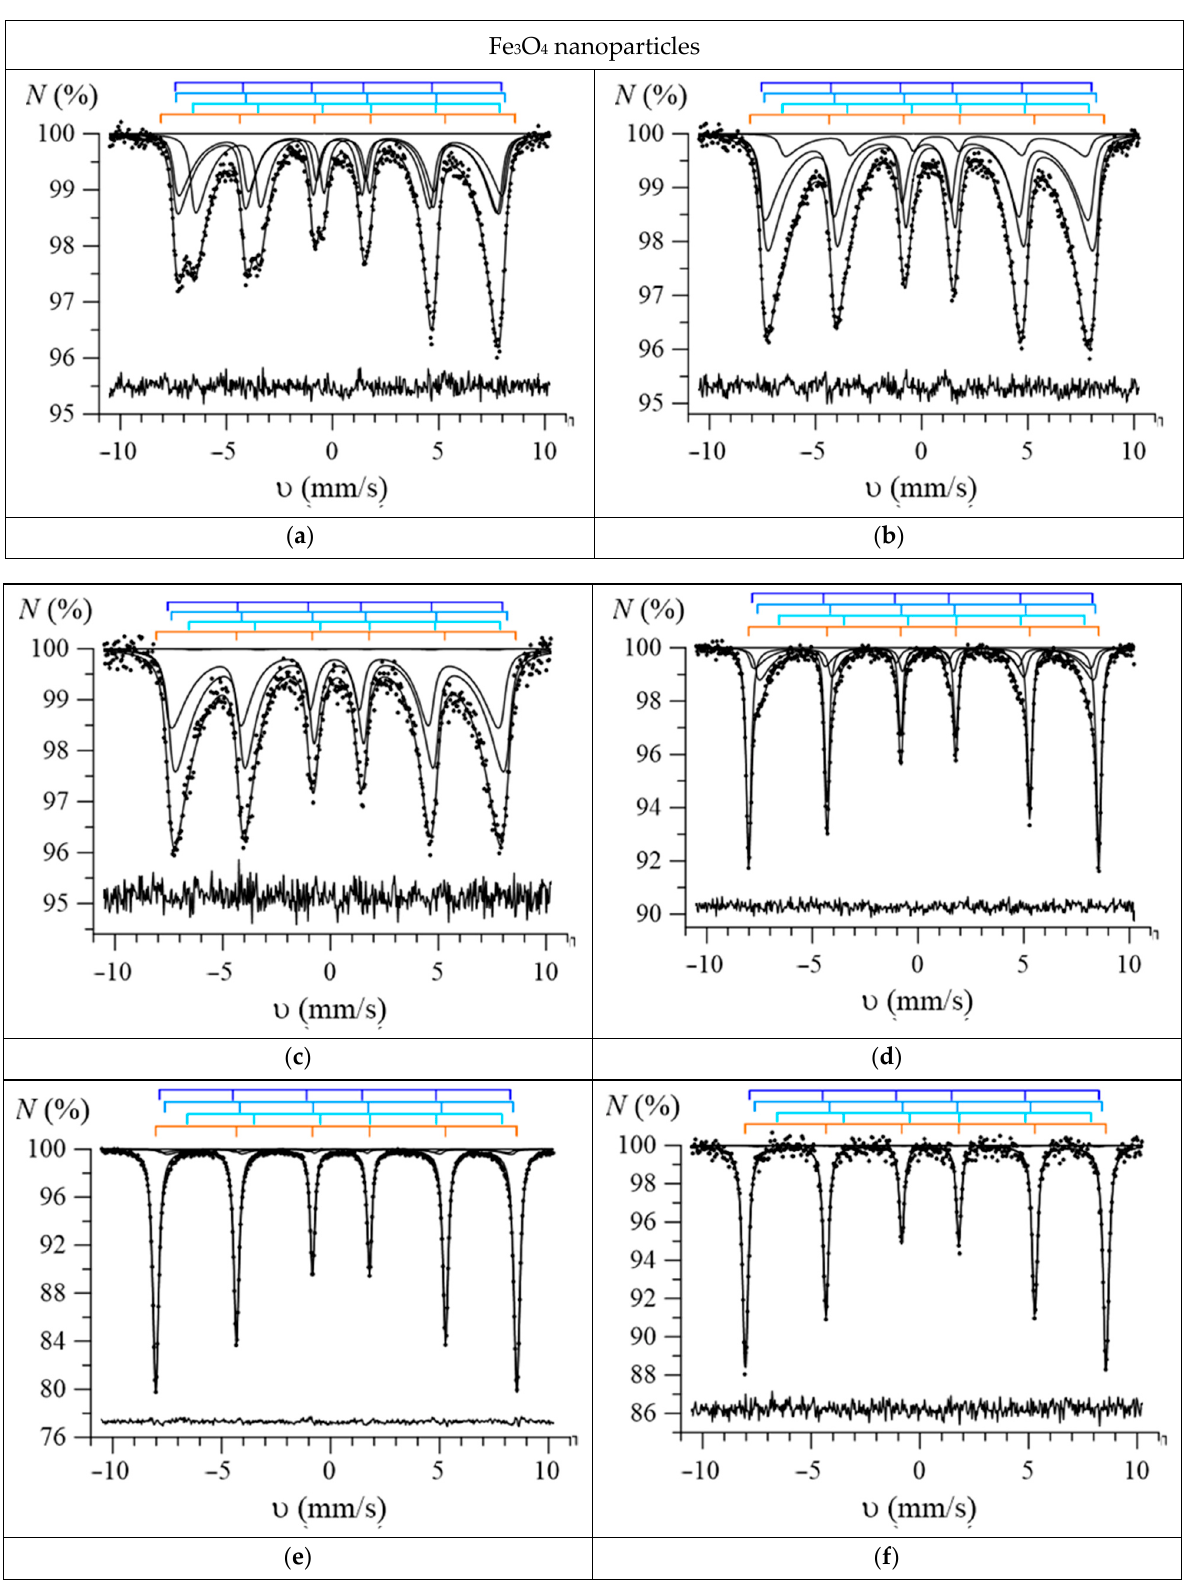
Figure 8. Mössbauer spectra of the initial ( a ) and annealed at temperatures of 100 °C ( b ), 200 °C ( c ), 400 °C ( d ), 600 °C ( e ), 800 °C ( f ) Fe 3 O 4 nanoparticles (on each spectrum the positions of the resonance lines of the subspectra used for model fitting are shown; the lines corresponding to magnetite are shown in blue, and the lines corresponding to hematite are shown in orange).